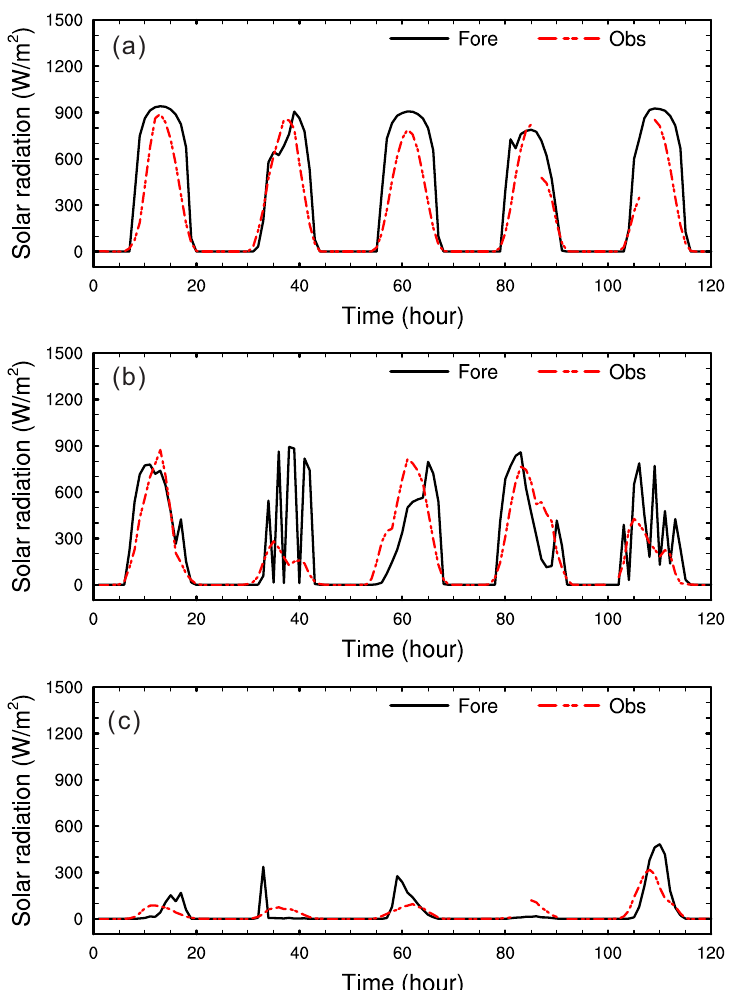
Figure 6. The solar radiation (W/m 2 ) series over five days of clear ( a ), cloudy ( b ) and overcast ( c ) sky conditions for the Maizuru site. The solid black and dotted red lines stand for forecasts and the corresponding observations,